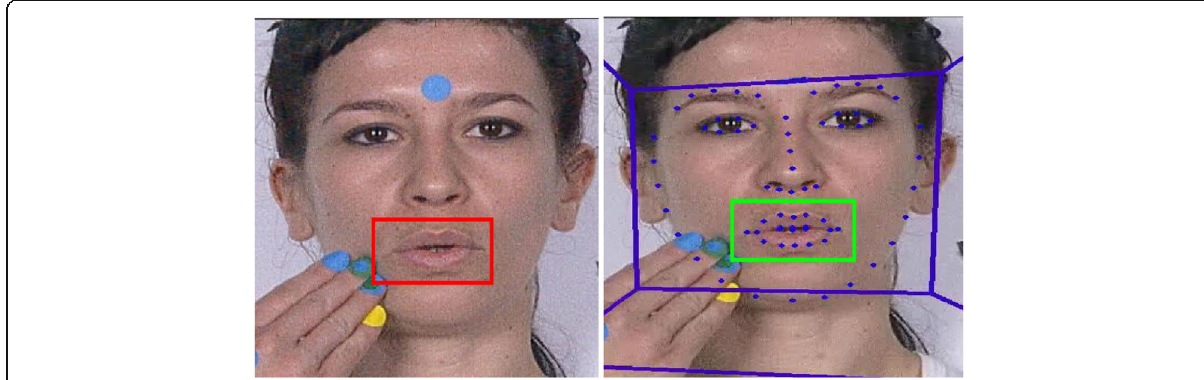
Fig. 12 Lips ROI determined by a blue mark in the front of the speaker ( left ). Lips ROI (the same size) determined by a center point estimated from CLNF landmarks ( right